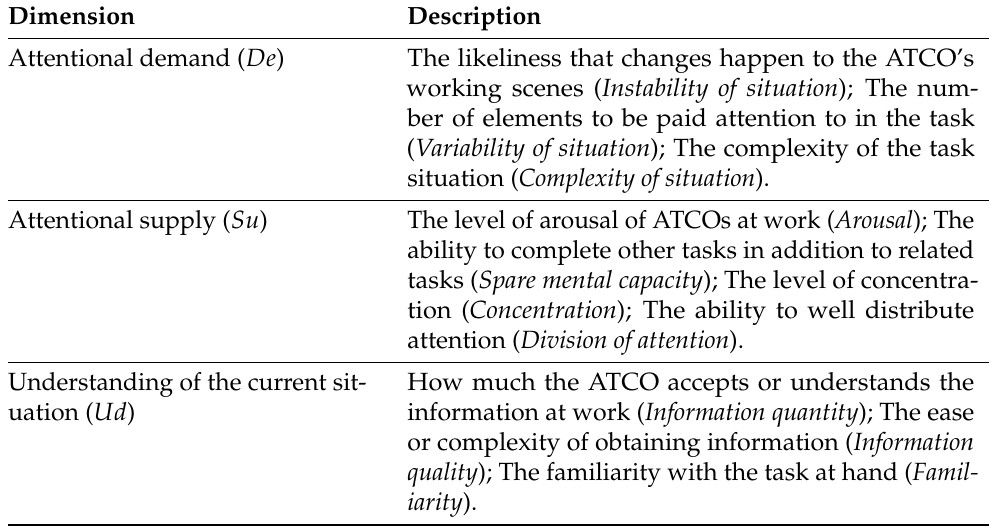
Table 4. 3D-SART scale dimension description.